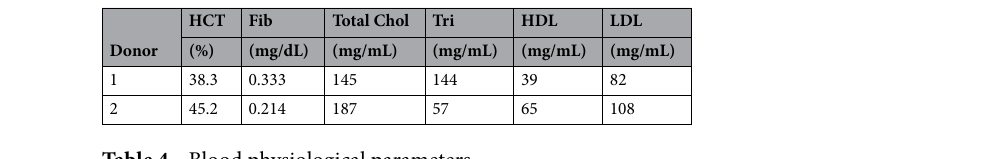
Table 4. Blood physiological